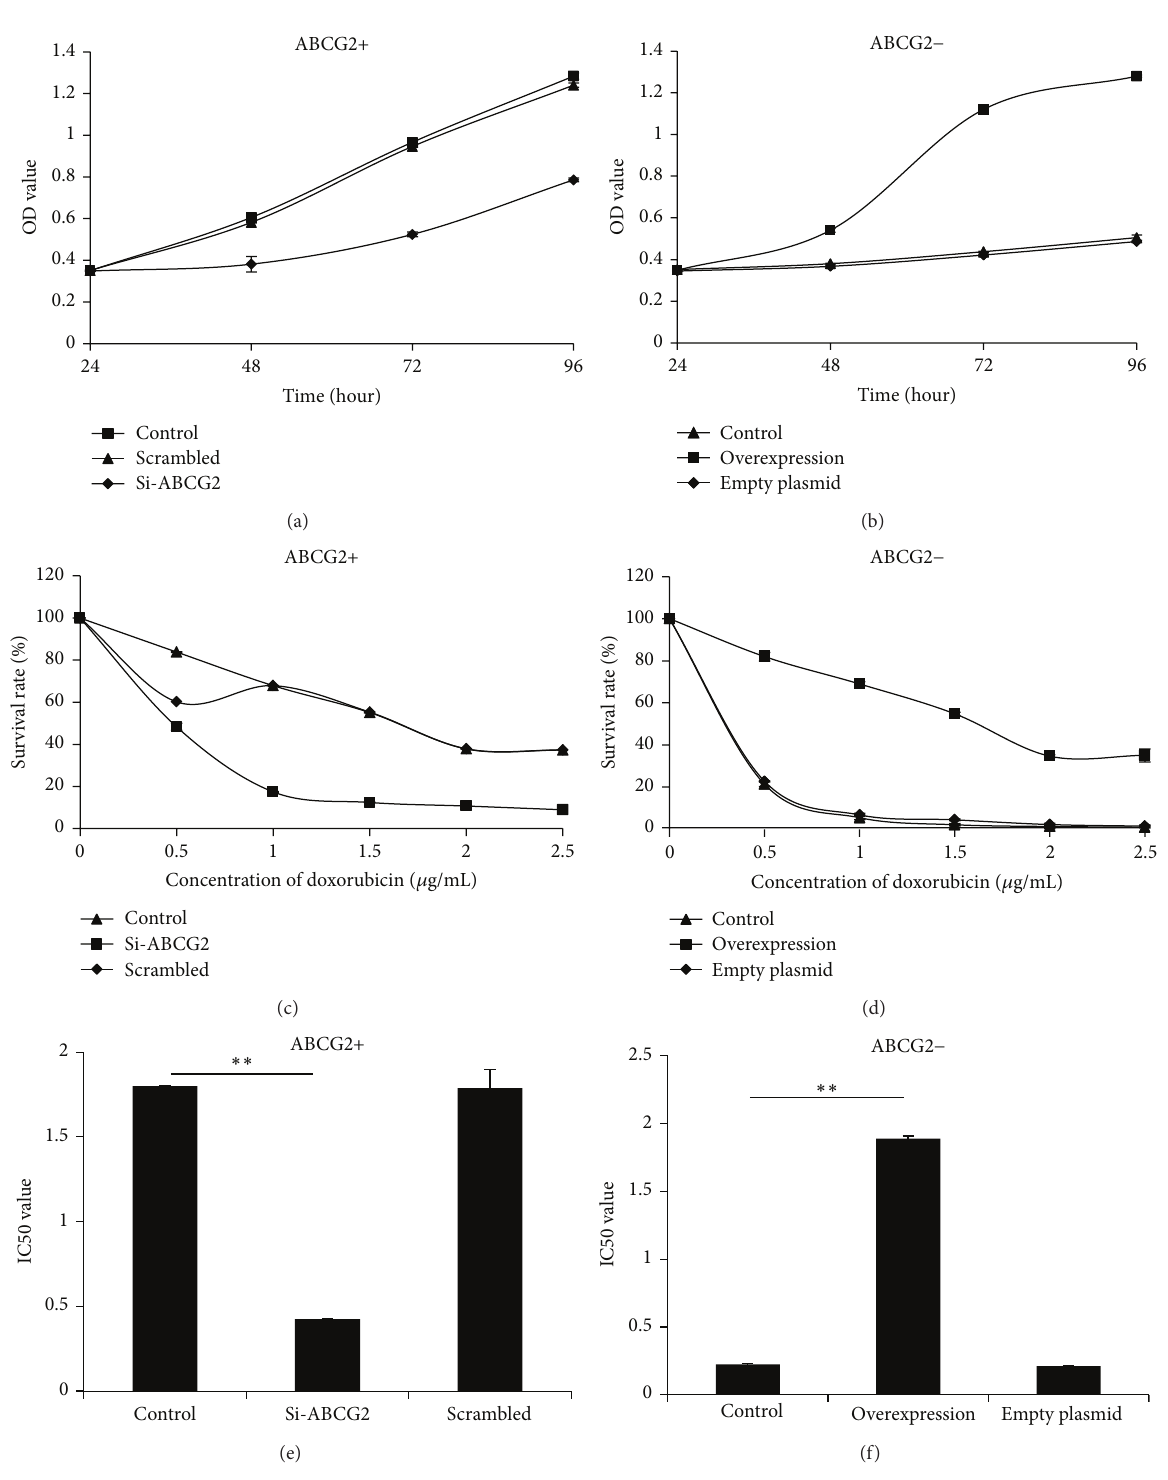
Figure 4: Expression level of ABCG2 correlated with cell proliferation and chemoresistance. (a), (b) Freshly sorted ABCG2+ cells were transfected with ABCG2-specific siRNA. ABCG2 − cells were transfected with ABCG2-overexpression plasmid. The proliferation of cells after transfection was compared with untransfected cells and negative control (scrambled siRNA or empty plasmid) using MTT assay after indicated time. (c), (d) The expression level of ABCG2 was manipulated as described above. Survival rates after exposure to indicated dose of doxorubicin for 24h were determined by MTT assay. (e), (f) IC50 value to doxorubicin was calculated for different groups. ∗∗ 𝑃 < 0.01